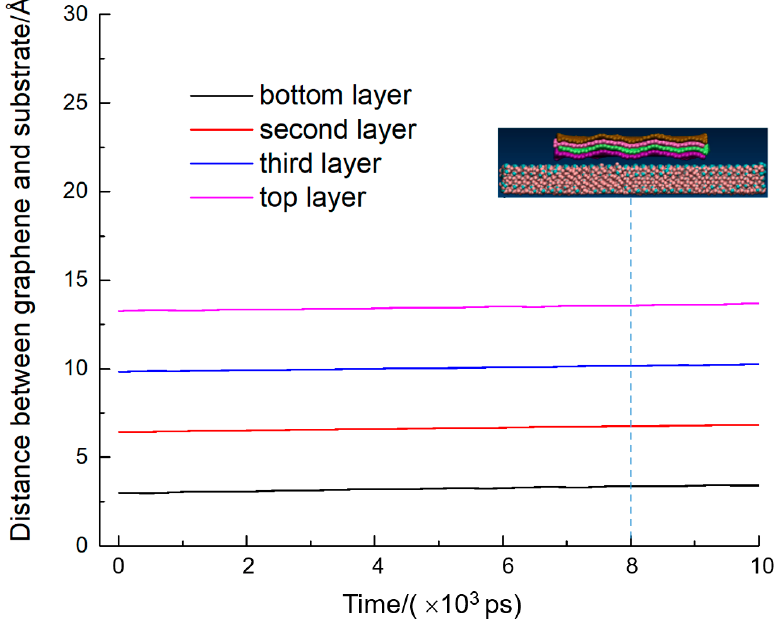
Figure 2. Exfoliation process in four-layer graphene system, when the vertical upward velocity was 0.4 Å/ps. The dotted blue line shows the trajectory at different points in time.